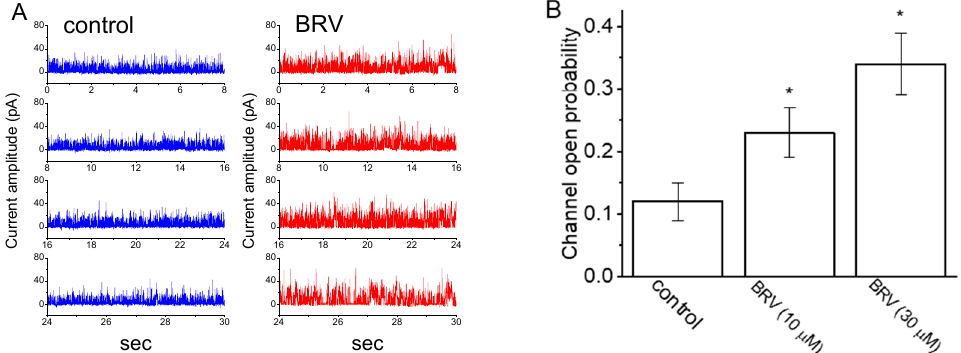
Figure 8. Stimulatory effects of BRV on the activity of BK Ca channels identified in mouse mHippoE-14 hippocampal neurons. In these experiments, cells were bathed in high K + solution containing 1 µ M of Ca 2+ ; inside-out current recordings were performed, and channel activity was measured at a holding potential of +60 mV. ( A ) Representative channel current traces obtained in the control period (left, blue color) and after bath addition of 10 mM BRV (red color). Channel-opening event is denoted as an upward deflection (i.e., outward current); ( B ) Summary bar graph showing effects of BRV on the probability of channel opening during exposure to 10 or 30 mM of BRV (mean ± SEM; n = 8). * Significantly different from control ( p <